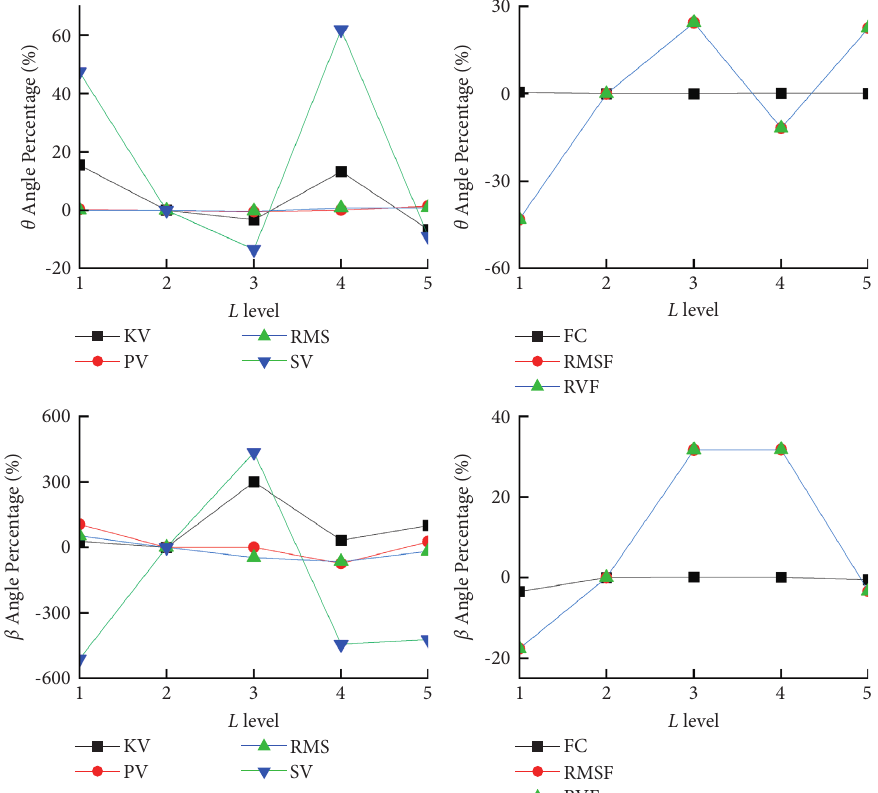
Figure 16: Effect of the rope length on the lift-slewing